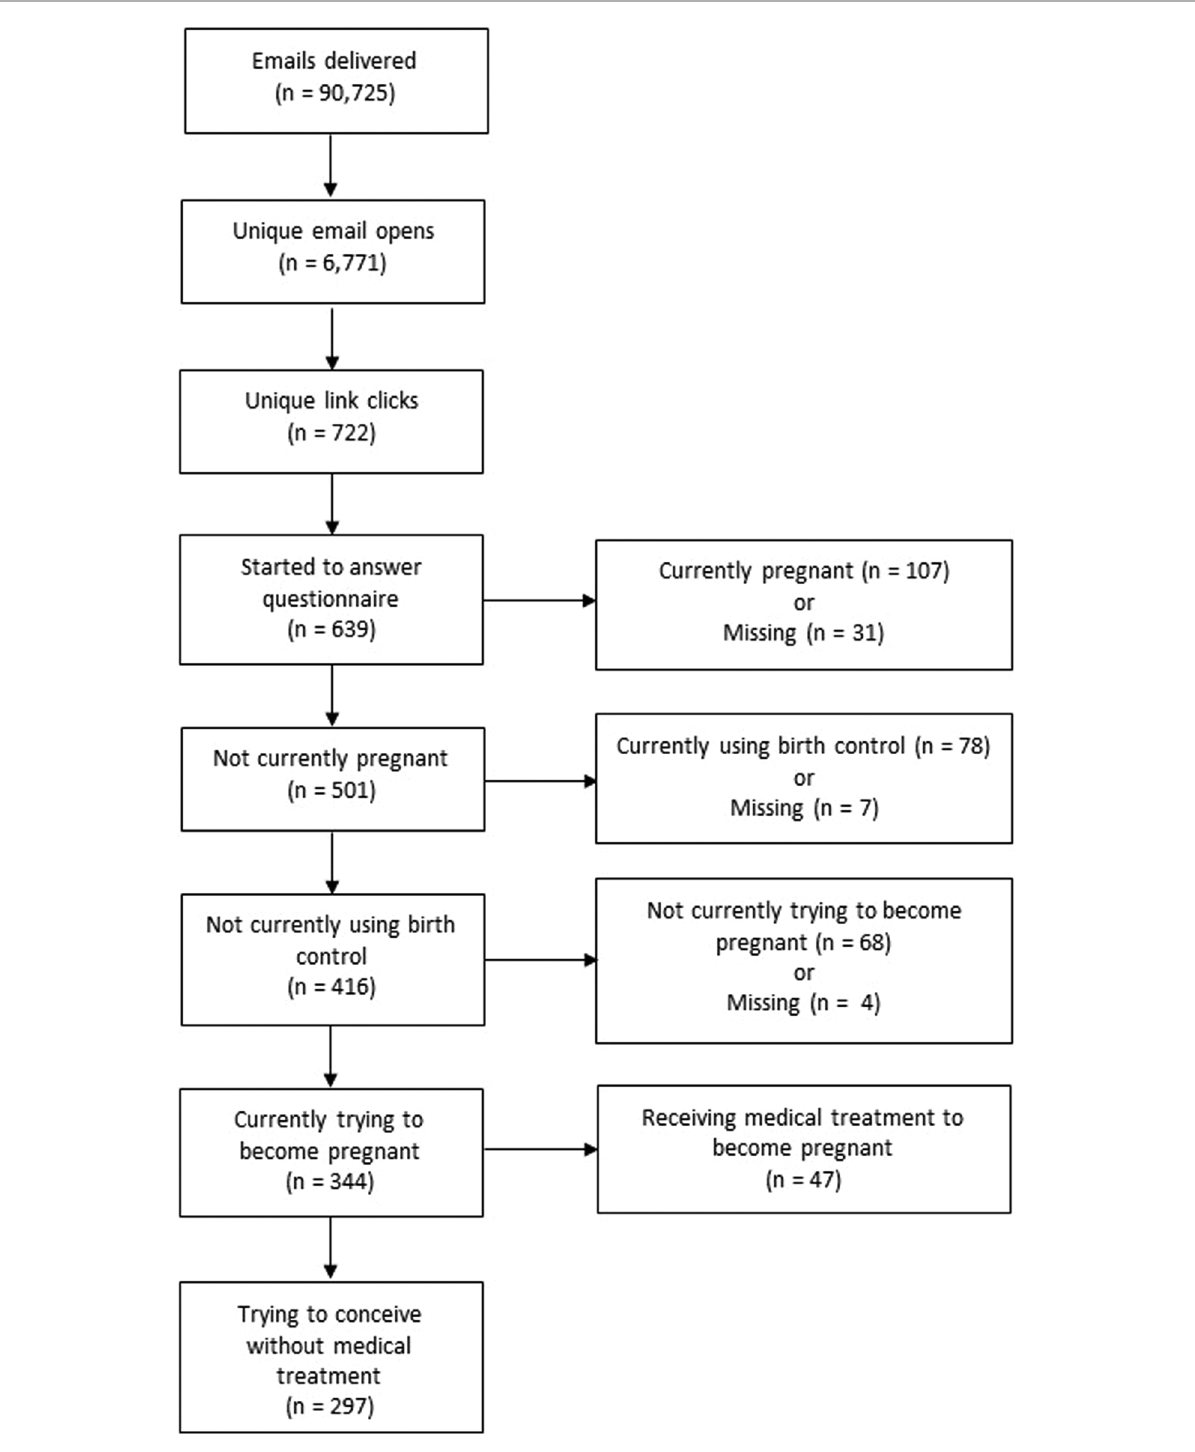
FIGURE 1 Flow chart of participant